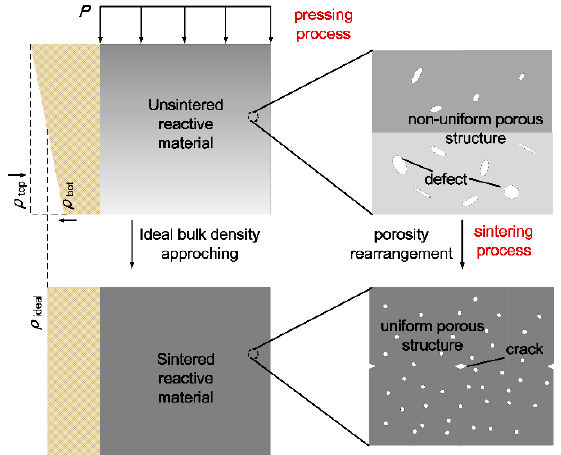
Figure 7. Schematic of gradient molding pressure induced cracks.